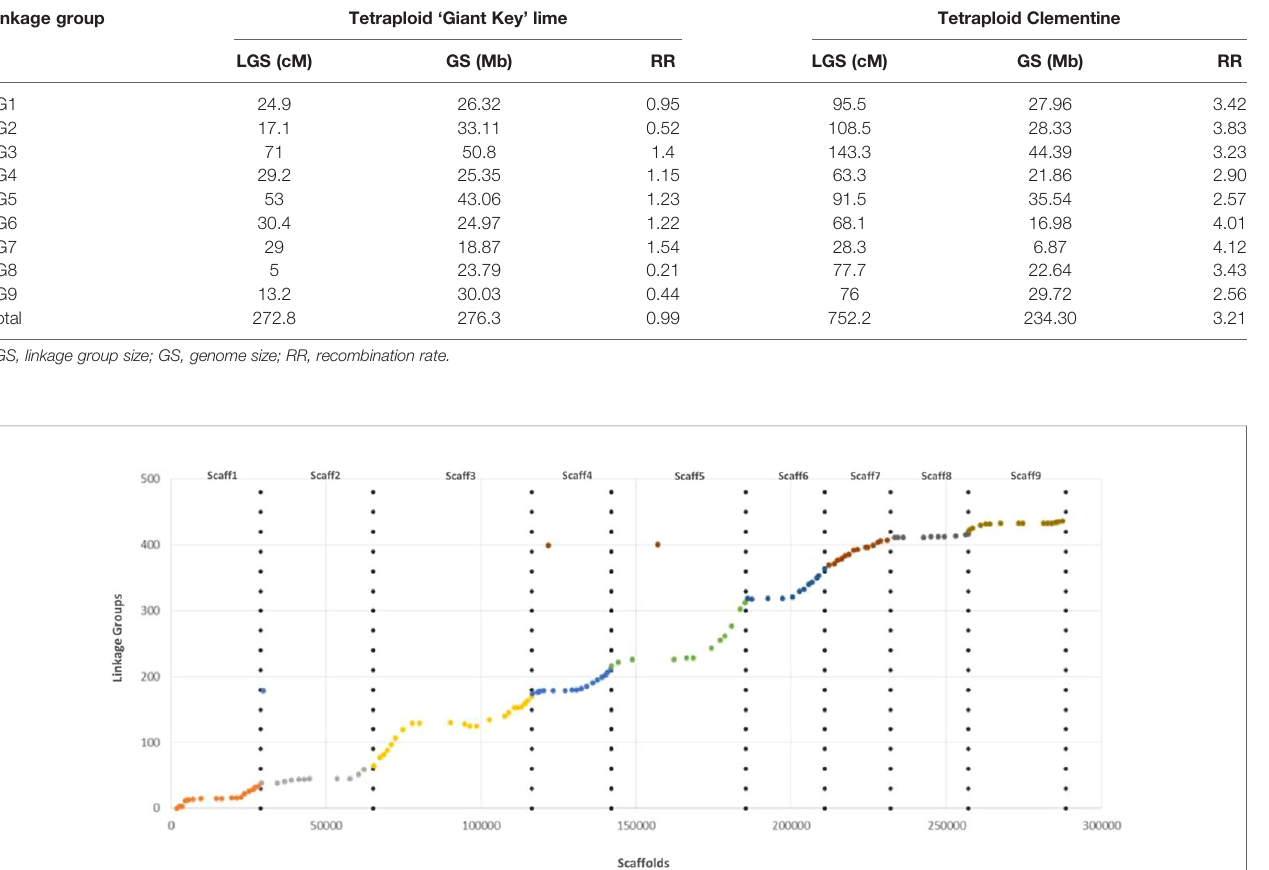
TABLE 4 | Linkage group size (cM), genome size of the mapped chromosome parts (Mb), and average recombination rates per LG (cM/Mb-1) for tetraploid ‘ Giant Key ’ lime and tetraploid clementine. Linkage group Tetraploid ‘ Giant Key ’ lime